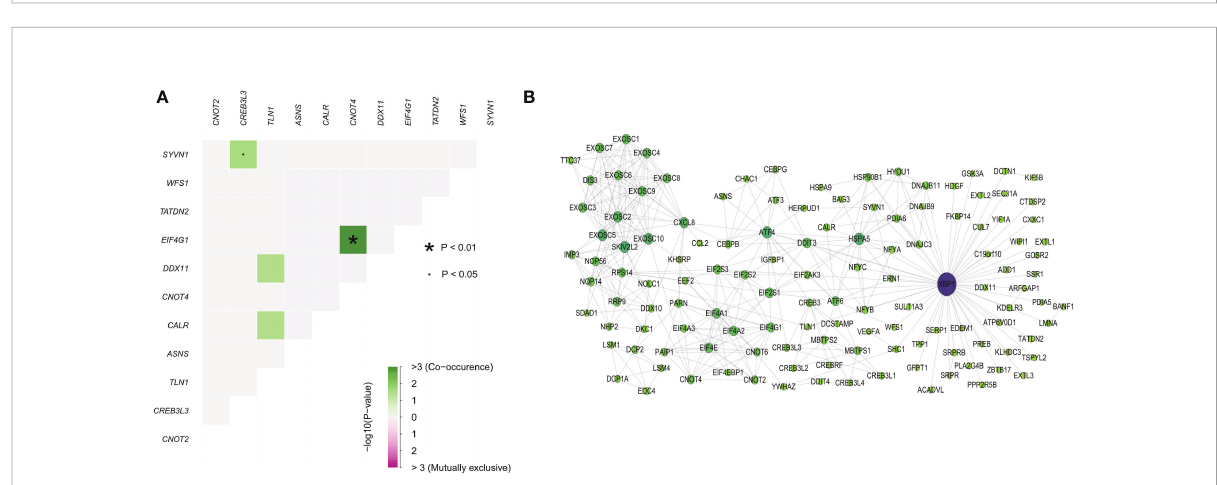
FIGURE 5 Endoplasmic reticulum stress factor comutations and protein interaction networks. (A) Comutation of ER stress factor with SNV mutation frequency greater than 1% in LIHC; (B) Protein interaction network of ER stress